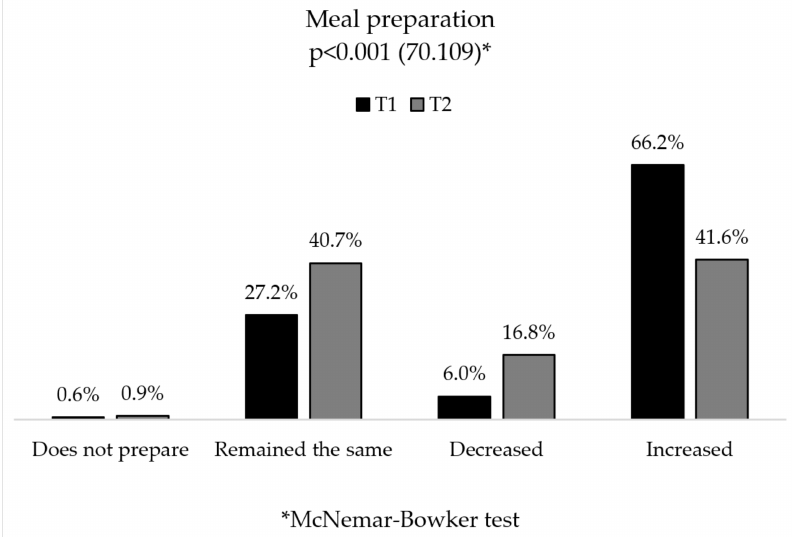
Figure 4. Changes regarding the amount of food ingested, use of delivery services, habit of snacking and meal preparation in the first and second phases of the research. *: p < 0.001. Data referring to meals eaten in the period before the pandemic (T0) and at both moments during the pandemic (T1 and T2) demonstrated that the number of people having a morning snack and other non-traditional meals increased at T1. At T2, the number of people having a morning snack increased again while it decreased for other meals. These changes were statistically significant ( p < 0.001 and p = 0.015, respectively), whereas there were no significant changes regarding the other meals—breakfast, lunch, afternoon snack, dinner and supper—when comparing the three moments (Figure 5).